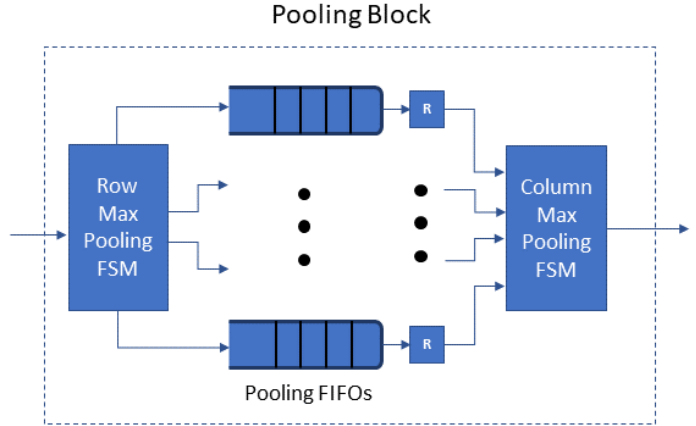
Figure 3. Pooling block architecture.